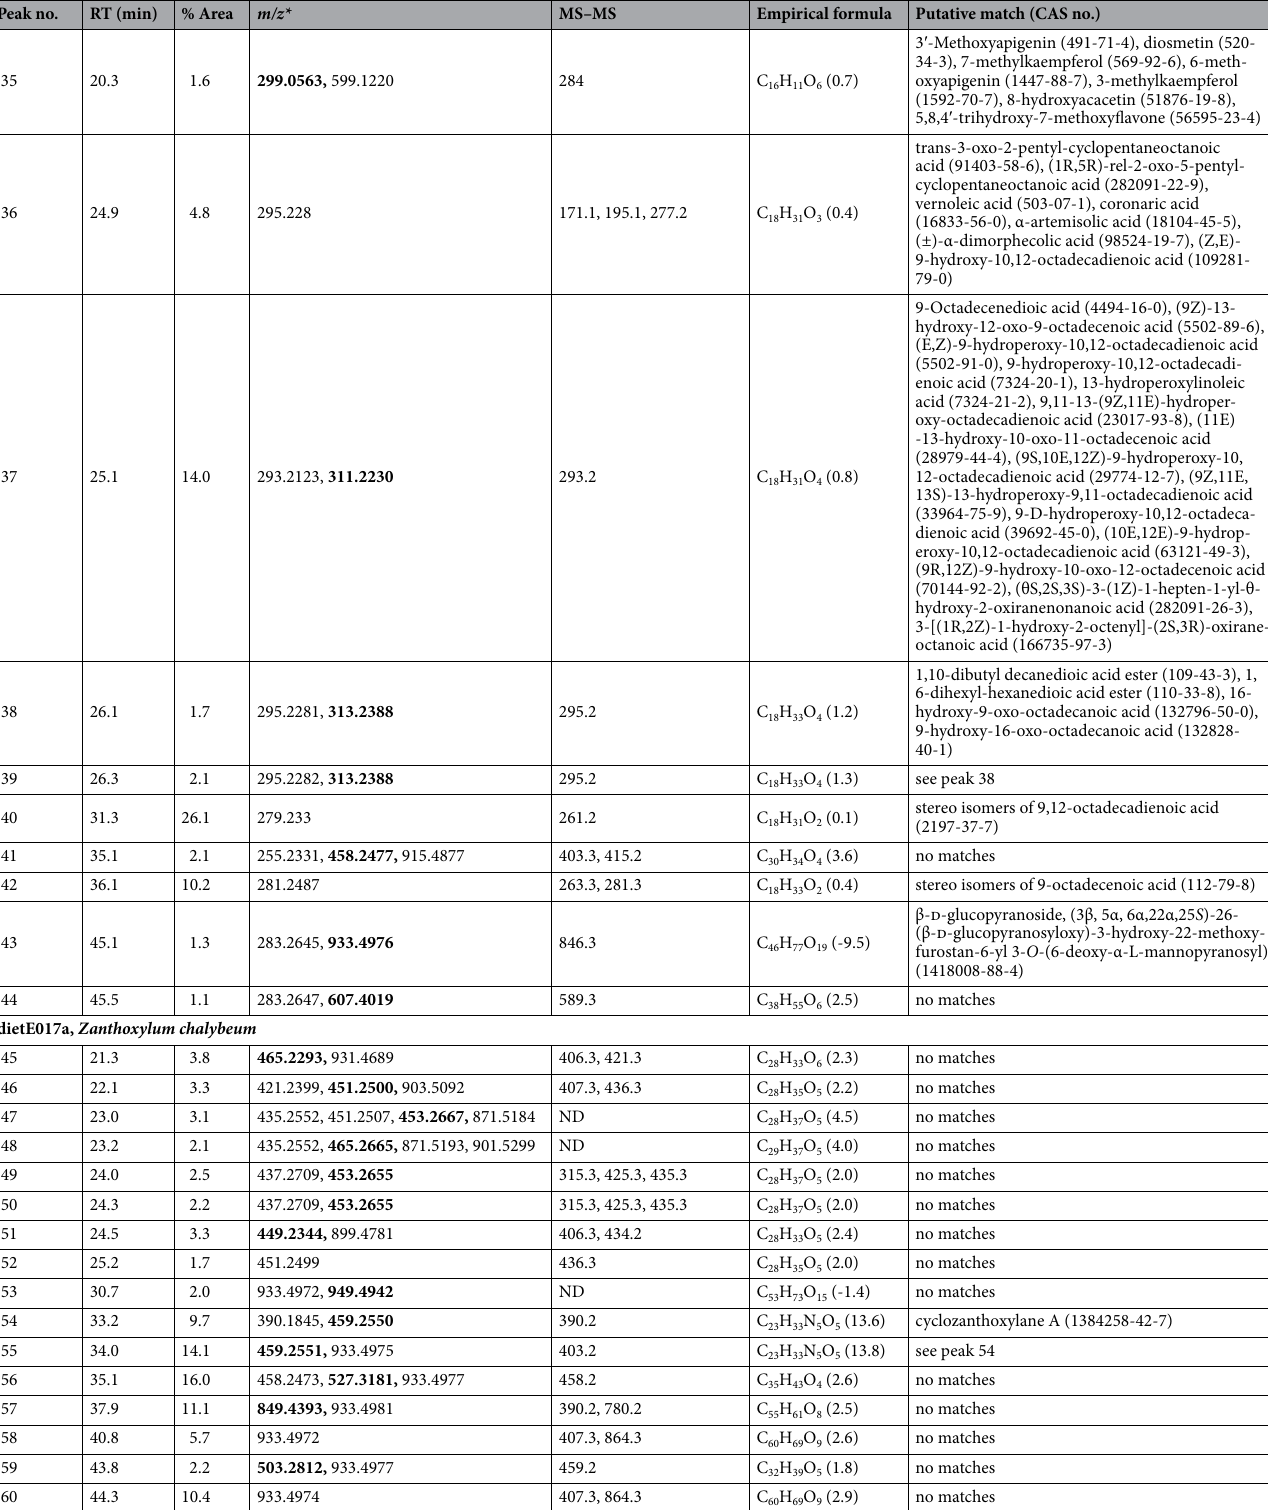
Table 5. LC–MS data and putative matches for extracts etE011-18, hE004-18, eE006, and dietE017a. ND, not detected. *When multiple base ions were detected, the m/z in bold fond indicates the ion used to predict the empirical formula and which underwent MS 2